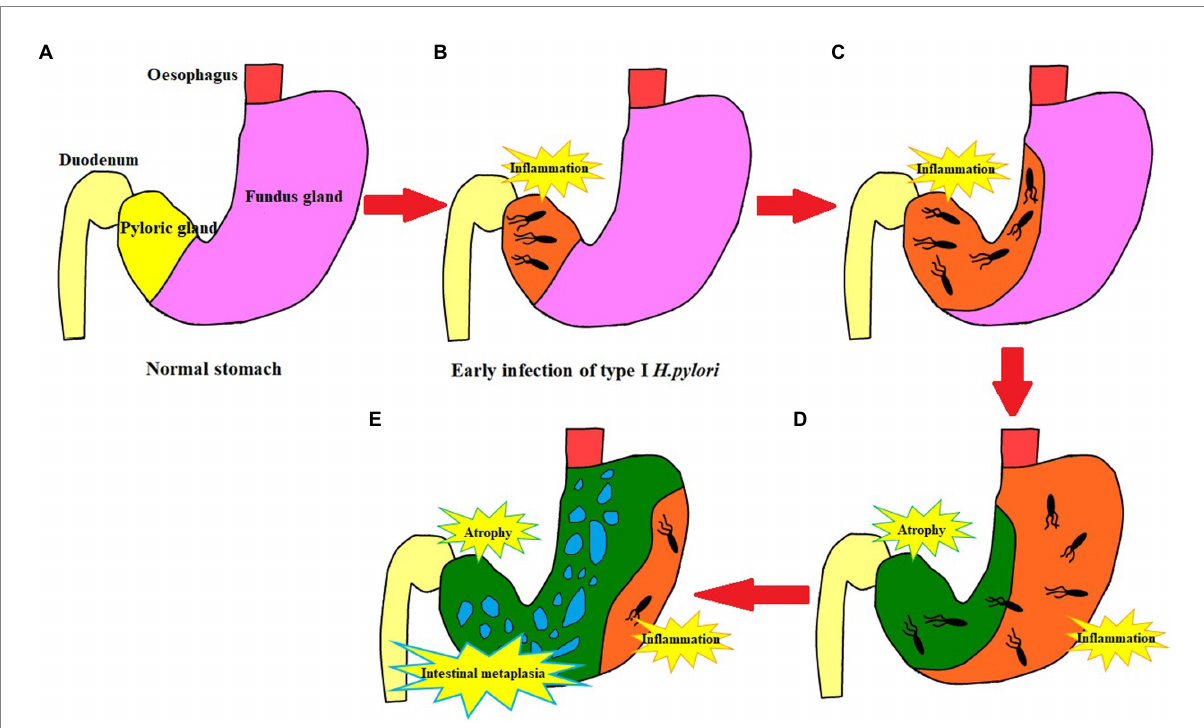
FIGURE 5 Schematic diagram of type I H. pylori infection. (A) Normal stomach structure. (B) The initial stage of type I Helicobacter pylori infection is limited to the gastric antrum. (C) Type I H. pylori infection progresses to the lesser curvature of the stomach. (D) Lesser curvature atrophy; Type I H. pylori infection extends from lesser curvature to greater curvature; Inflammation affects the whole stomach. (E) With the lesser curvature as the center, the atrophy extends to the periphery, accompanied by intestinal metaplasia and persistent active inflammation in the greater curvature.